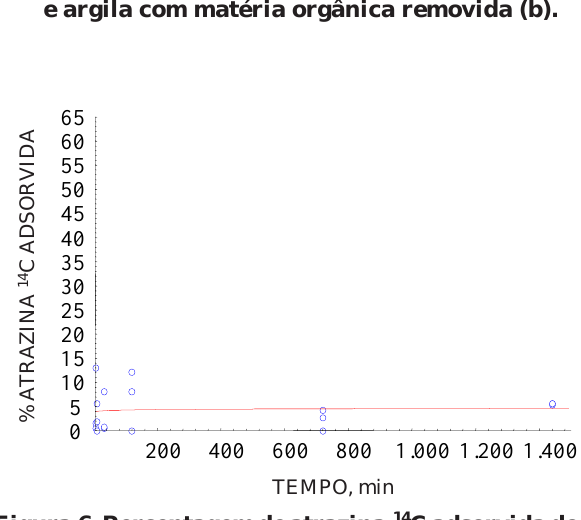
Figura 6. Percentagem de atrazina- 14 C adsorvida do total adicionado em materiais de Latossolo Roxo com matéria orgânica e óxidos de ferro